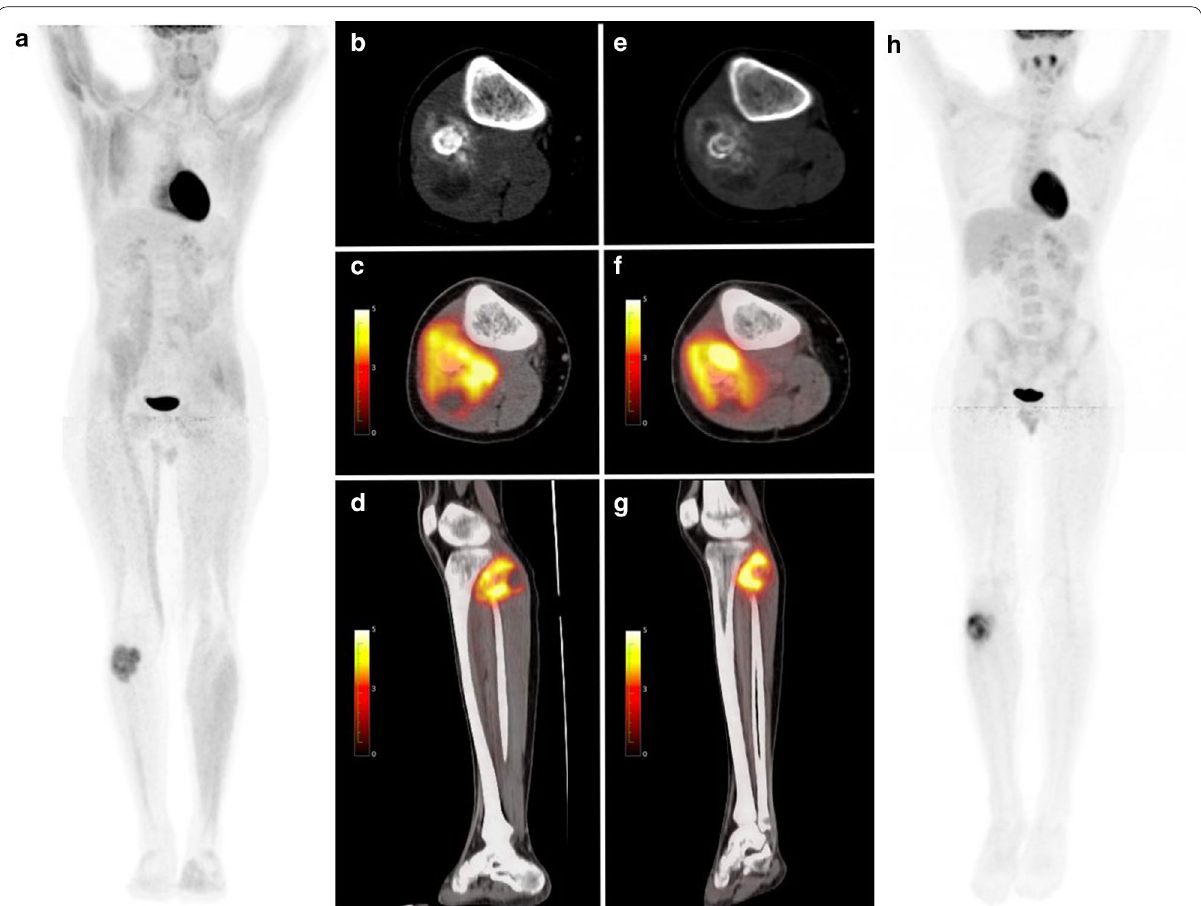
Fig. 5 Eighteen‑year‑old boy diagnosed with osteosarcoma. PET‑1 ( a , b ) showed [18F]FDG avid lesion in the right proximal fibula (SUVmax 6.6; MTV 102.2 mm 3 ; TLG 91). PET‑2 ( c , d ) did not show major [18F]FDG uptake changes after neo‑CTX (SUVmax 8.6; MTV: 67.2; TLG: 80.6). Patient underwent surgery (proximal fibular and mass resection) and viable tumor was seen in the resected specimen. After completion of adjuvant CTX patient developed lung metastatic disease. Patient was alive with disease at last follow up. PET1, a PET 3D MIP, b CT axial view, c fused PET/CT axial view, d fused PET/CT sagittal view. PET2, e CT axial view, f fused PET/CT axial view, g fused PET/CT sagittal view, h PET 3D